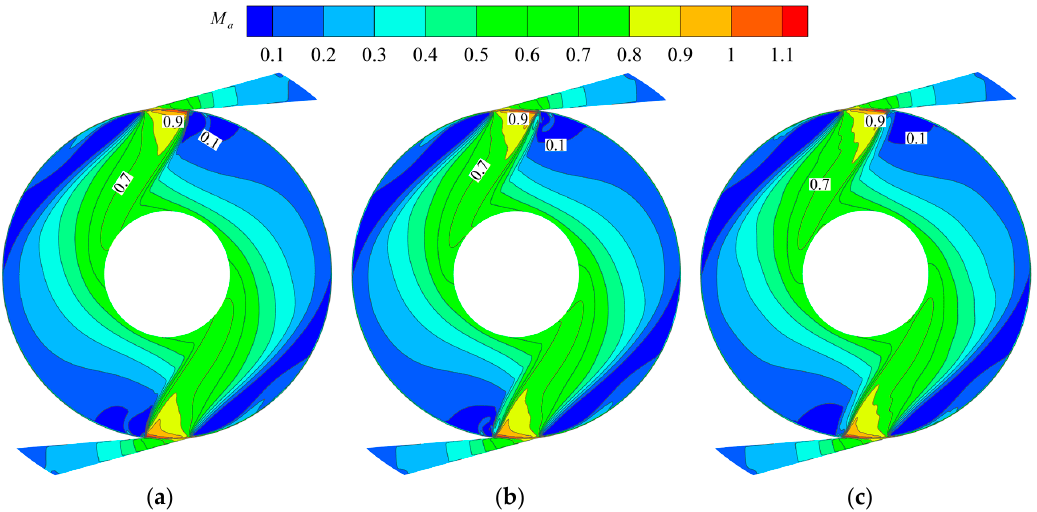
Figure 3. Mach number contours on the mid-sections of DC1 for the one-to-many turbine Case 1-0.5 with three different node cases: ( a ) Case 1; ( b ) Case 2; and ( c ) Case 3.